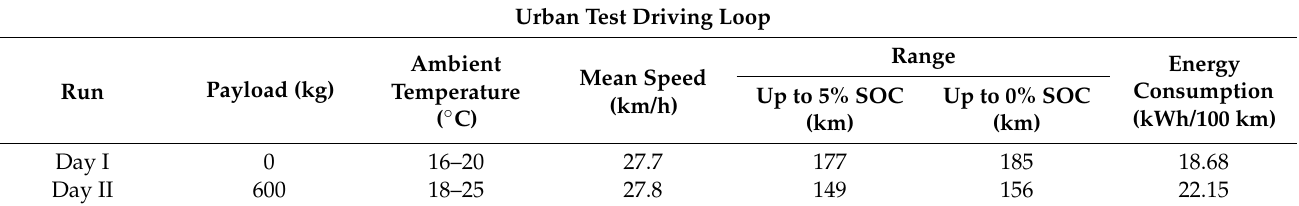
Table 6. Vehicle on-road range measurement